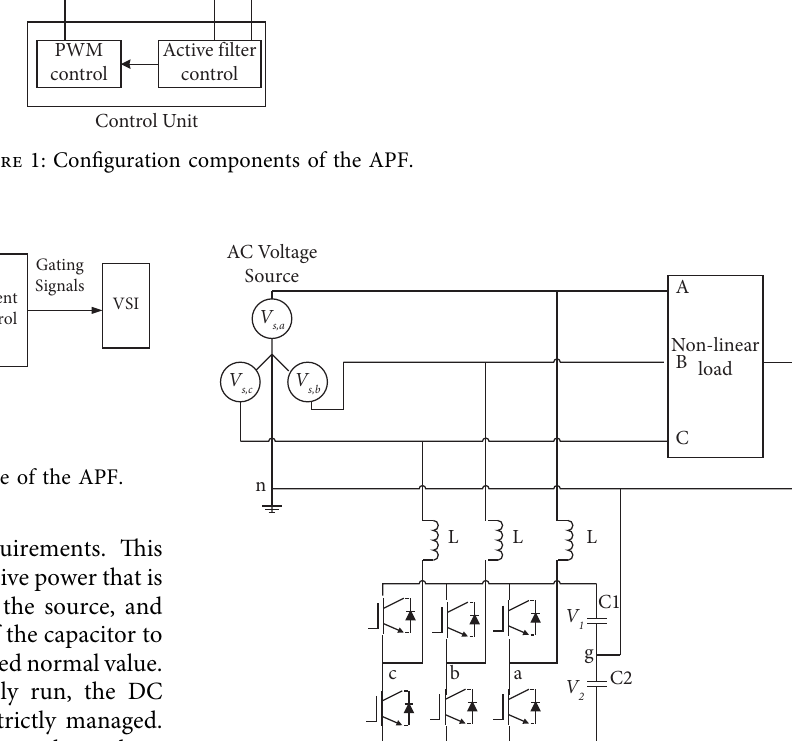
Figure 3: Te arrangement of the three-phase four-wire APF.